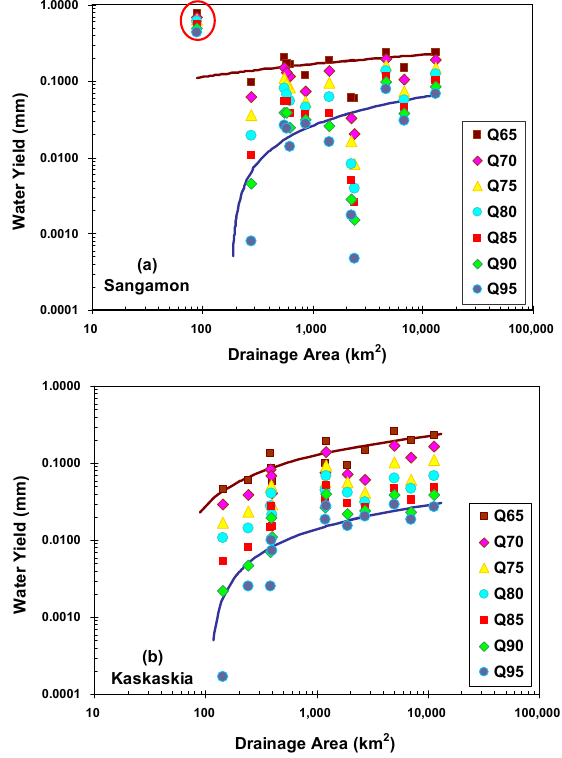
Fig. 10. Scaling of the lower limb of the FDC with drainage area in (a) Sangamon and (b) Kaskaskia. Note that the circled area in (a) is the Sugar Creek